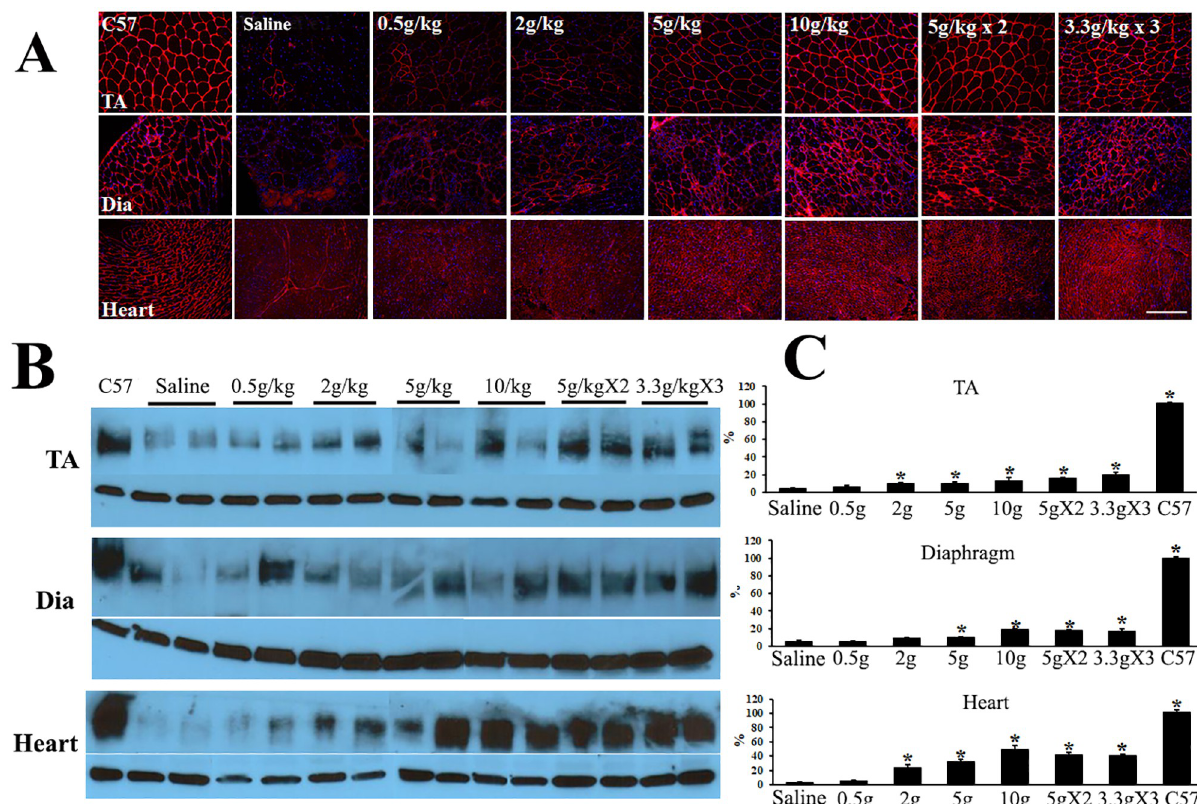
Fig 1. Six-month ribitol treatment enhances matriglycan expression dose-dependently in P448L FKRP mutant mice. (A) IIH6 immunohistochemistry for the detection of matriglycan. Saline treated as control. TA, Tibialis anterior. Dia, diaphragm. (B) Western blots for the detection of matriglycan with IIH6 antibody (with broad bands). Two samples for each dose are shown. The lower panels are α -actin as loading control. (C) measurement of the matriglycan bands by NIH ImageJ with C57 as 100% control. Saline, saline treated; 0.5g, 0.5g/kg; 5gX2, 5k/kg twice a day; 3gX3, 3g/Kg 3 times a day. � P < 0 . 05 n = 3 compared to the saline control group. Scale bar = 150 μ M.